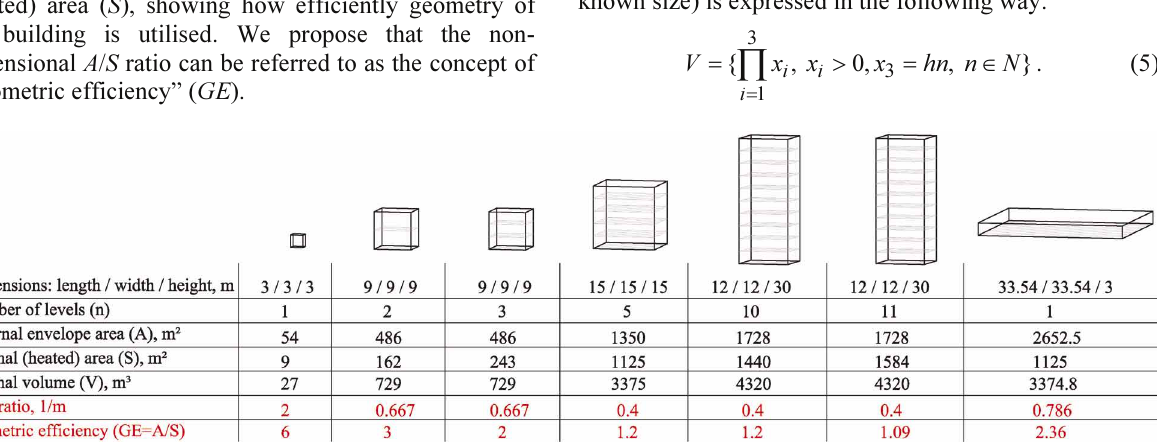
Fig. 1. A / V ratio and GE values of various orthogonal volumes of different sizes, shapes and number of